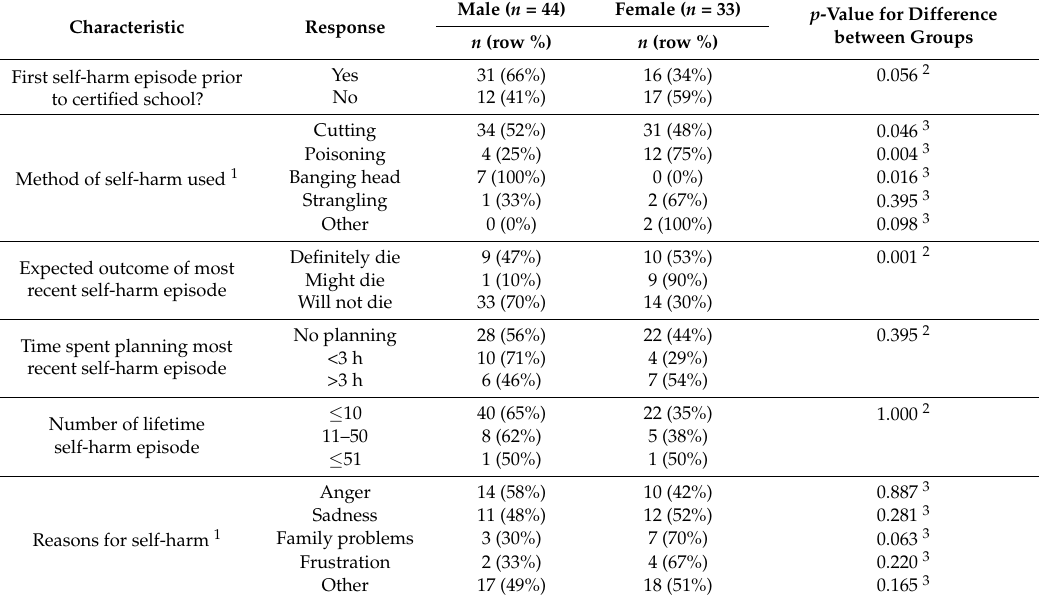
Table 2. Self-harm characteristics by gender reported by 77 young people detained in certified schools in Sri